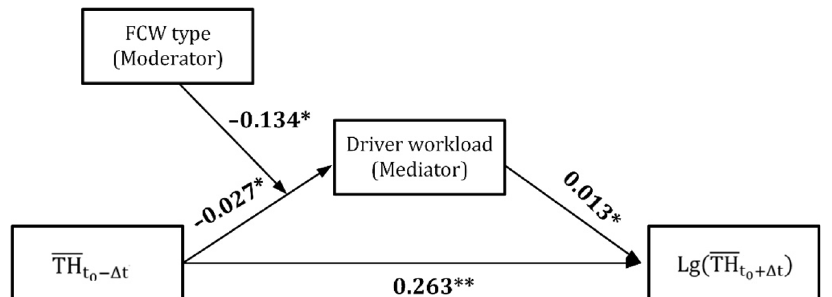
Figure 11 Mediated moderation between average time headway and collision avoidance performance